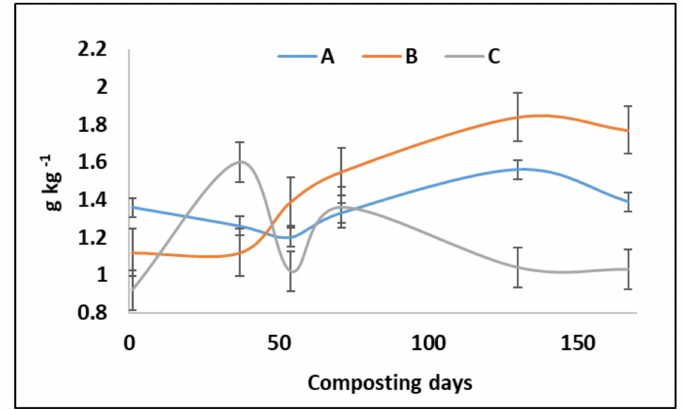
Figure 4. Changes in total phosphorus content [g kg − 1 ] during composting.